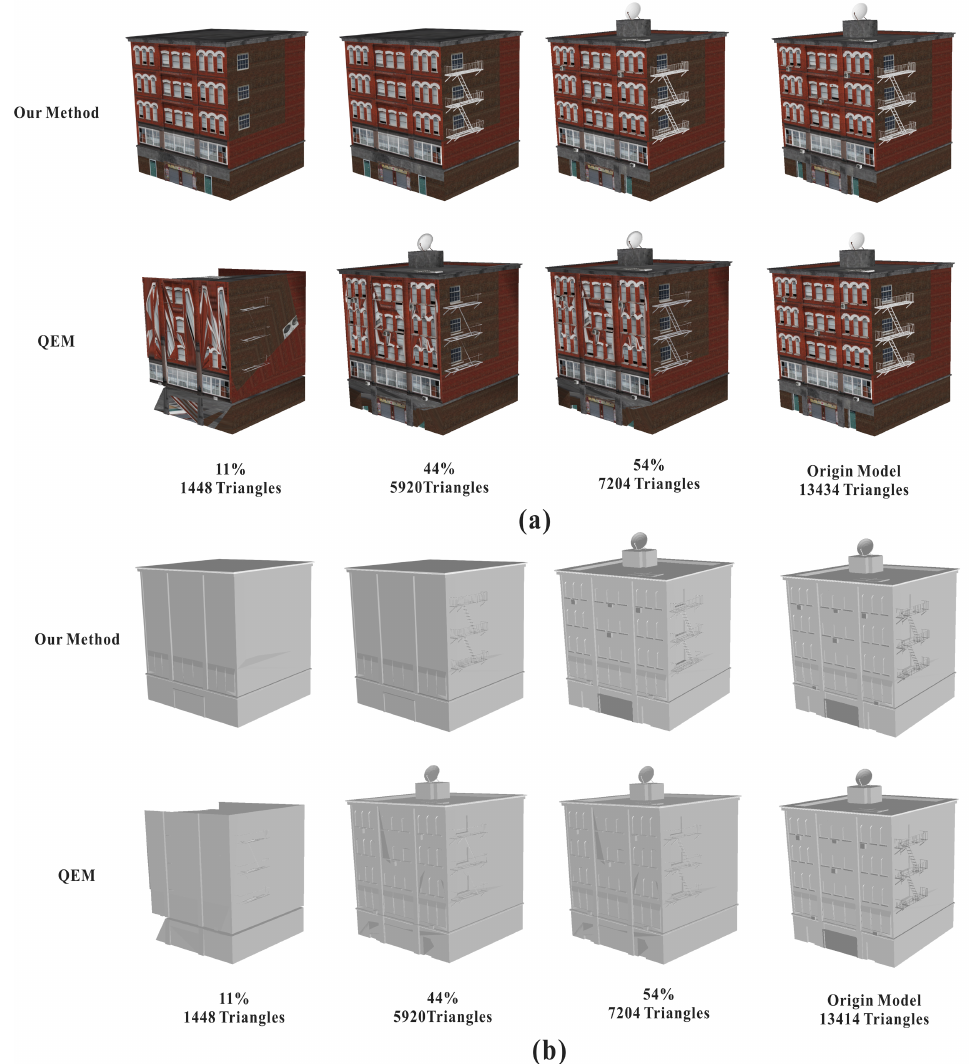
Figure 14. Comparison between the proposed method and the QEM algorithm on Model 3: ( a ) texture comparison result, and ( b ) geometric comparison result.